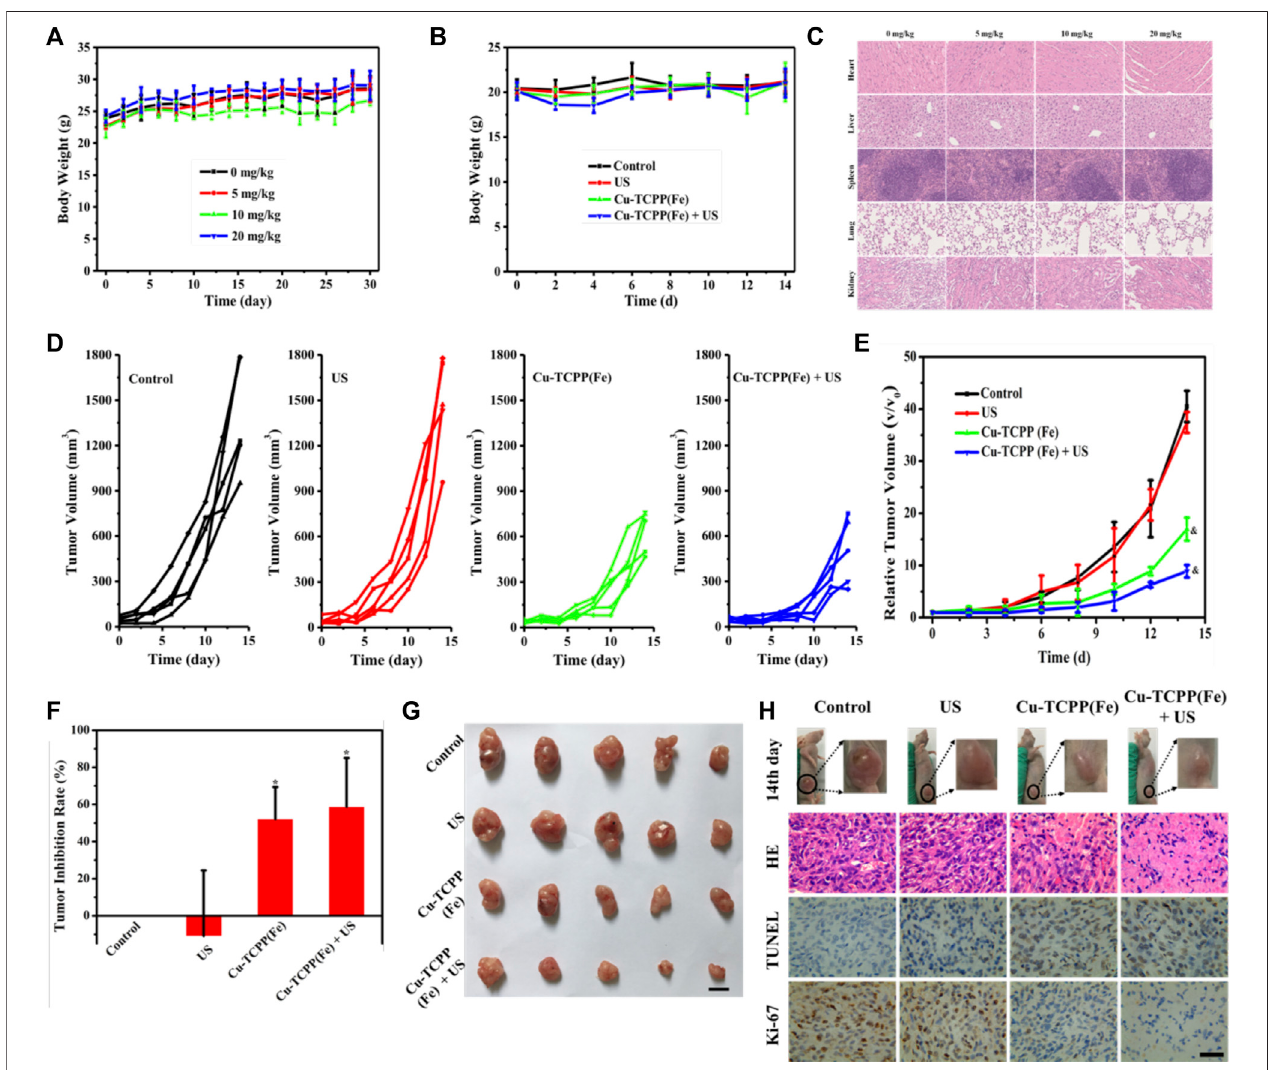
FIGURE 6 | In vivo synergistic SDT/chemical catalysis for tumor suppression. (A) The bodyweight of mouse changes in the biocompatibility evaluation. (B) Bodyweight changes of 4T1 tumor-bearing mice in different groups. (C) H&E-stained histological images of organs in the biocompatibility evaluation; scale bar: 50 μ m. Time-dependent tumor-growth curves (D) , relative tumor volume (E) , and tumor inhibition rate (F) of 4T1 tumor-bearing mice in four experimental groups ( n = 5), including the control group, US group, Cu-TCPP(Fe) group, and Cu-TCPP(Fe) + US group. (G) Photographs of the dissected tumors from four groups after 2 weeks of treatment (scale bar: 10 mm). (H) H&E staining, TUNEL staining, and Ki-67 immunohistochemical staining of tumor tissue from each group after different treatments (scale bar: 50 μ m). & p < 0.05, calculated by repeated measure ANOVA test. * p < 0.05, calculated by one-way ANOVA test.